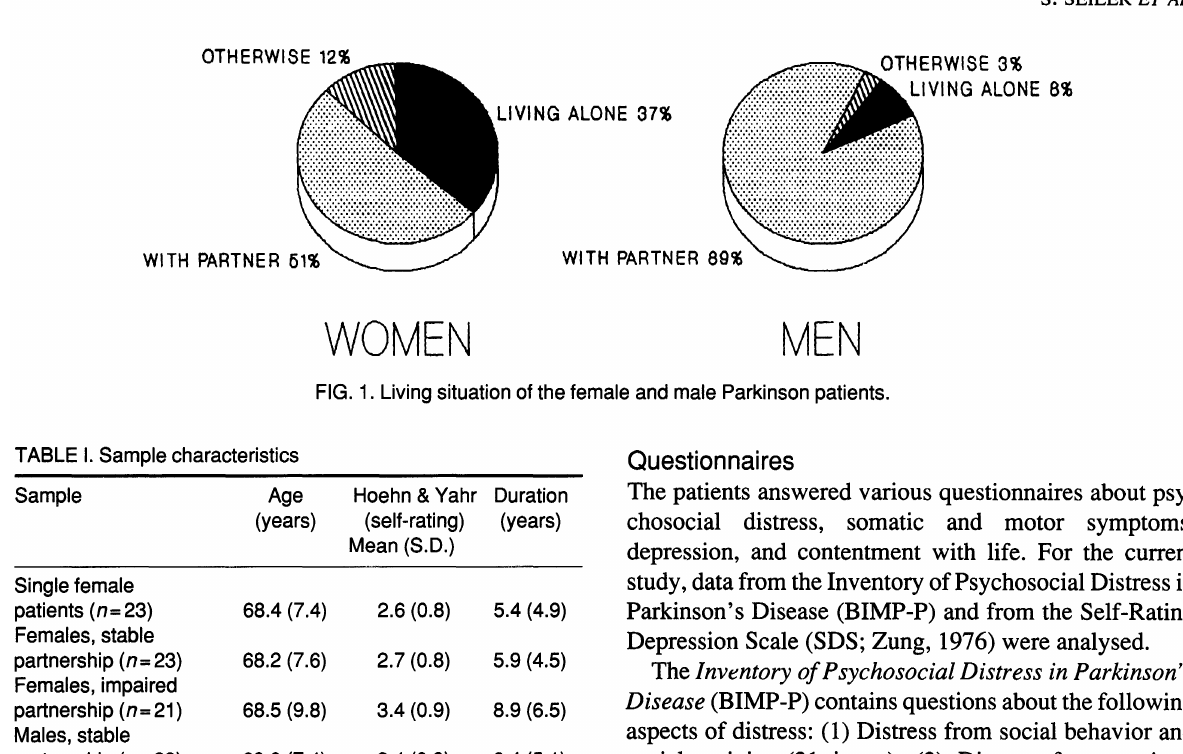
FIG. 1. Living situation of the female and male Parkinson patients. TABLE I. Sample